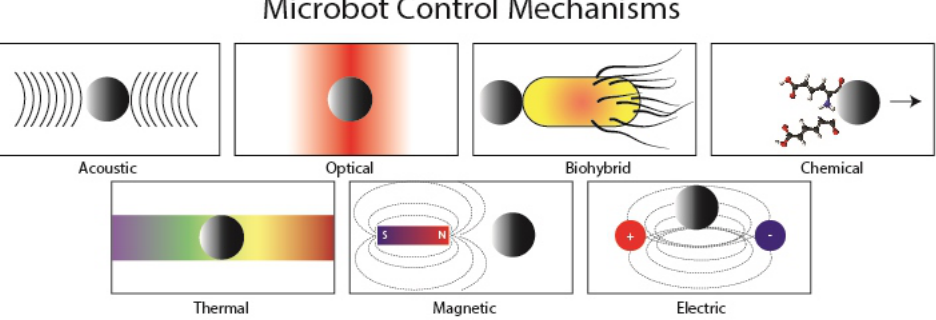
Figure 1. Different control mechanisms for microbot